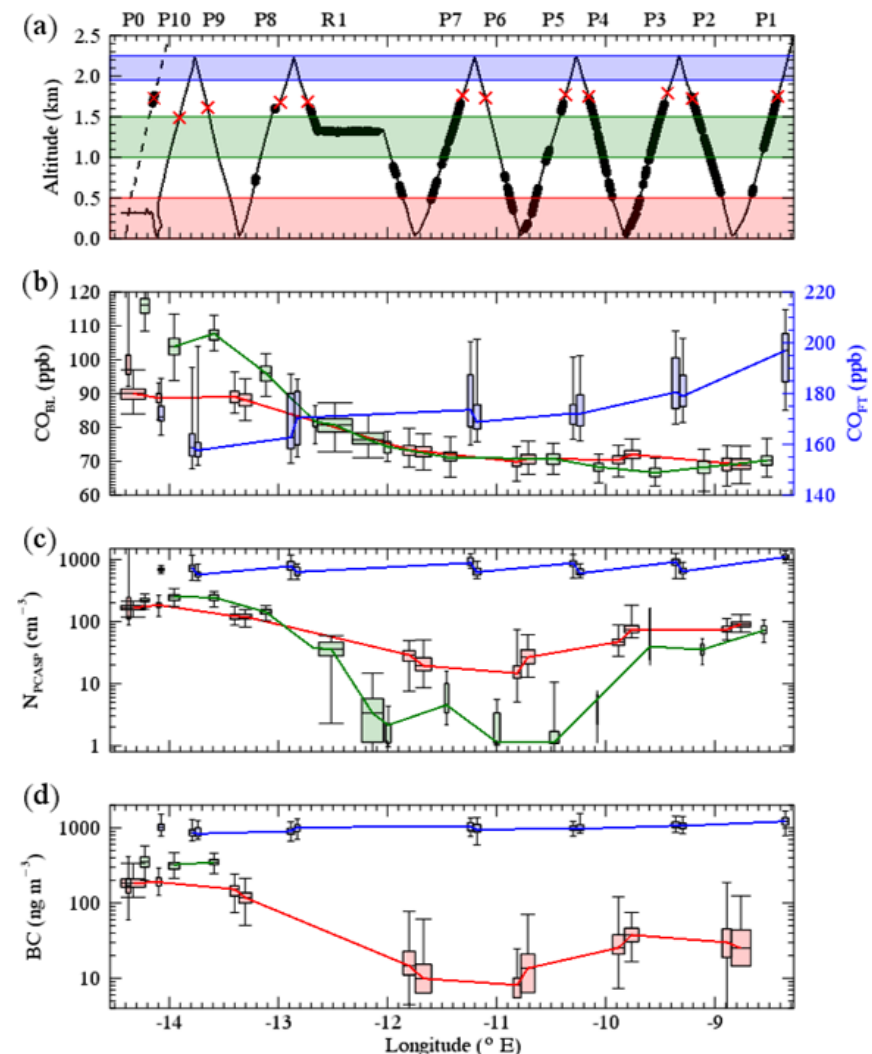
Figure 7. Aircraft data from flight C052 plotted as a function of longitude. Panel (a) shows the aircraft altitude on the initial profile out of Ascension Island (dash line) and on the low-level return leg through the POC feature (solid line). The black filled circles overlaid on the flight track indicate where cloud or precipitation was sampled (Nevzorov TWC sensor > 0.01gm − 3 ). The red crosses show the altitude of the base of the trade-wind inversion, that was identified visually from the temperature and humidity measurements. The shaded regions indicate the altitude ranges used to calculate the data presented in panels (b–d) . These correspond to data from the surface mixed layer (red), the ultra-clean layer (green) and the free troposphere (blue). Panels (b–d) present along-track measurements of CO, PCASP number concentration and BC mass concentration as box and whisker plots in the three altitude segments. Note that BC mass concentrations in the UCL (green) were below the detectable limit east of 12 ◦ W and that the free-tropospheric CO data in panel (b) uses the right-hand y axis. Profile and run names are indicated at the top of the